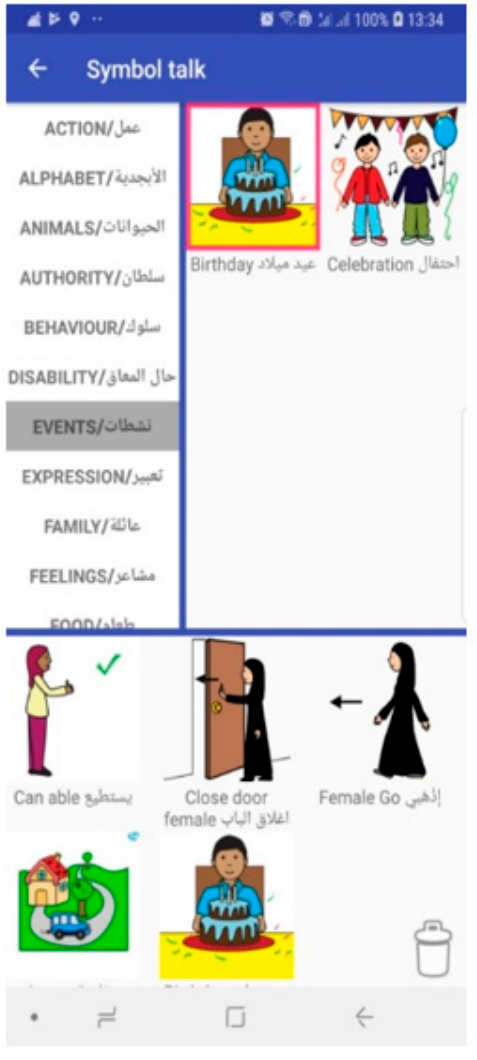
Figure 2. Tawasol symbols used in symbol talk functionality. This example shows how a female refugee child explains that as a girl she is able to leave the house and go to a birthday party